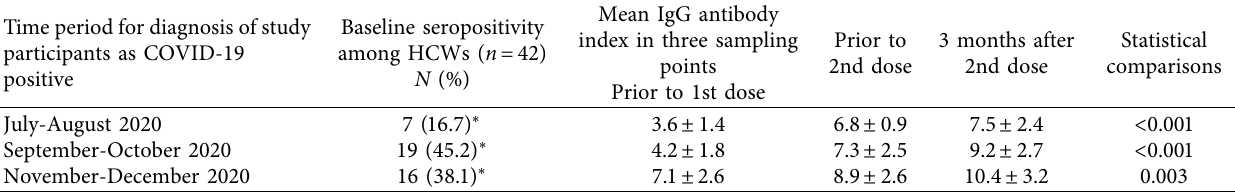
Table 2: Analysis of COVID-19 seropositivity among HCWs with prior history of COVID-19. Time period for diagnosis of study participants as COVID-19